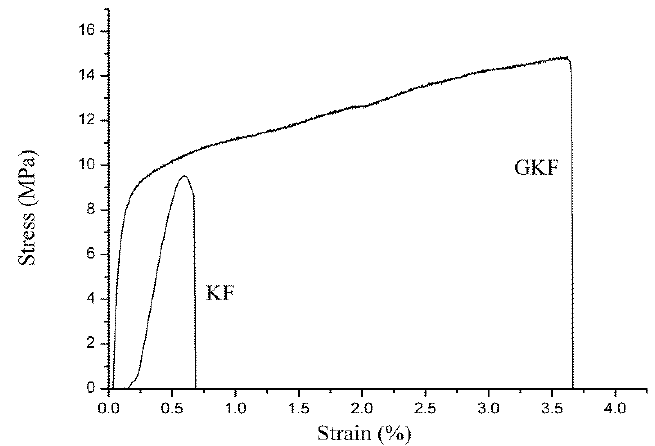
Figure 10. Tensile mechanical properties of different keratin film samples.